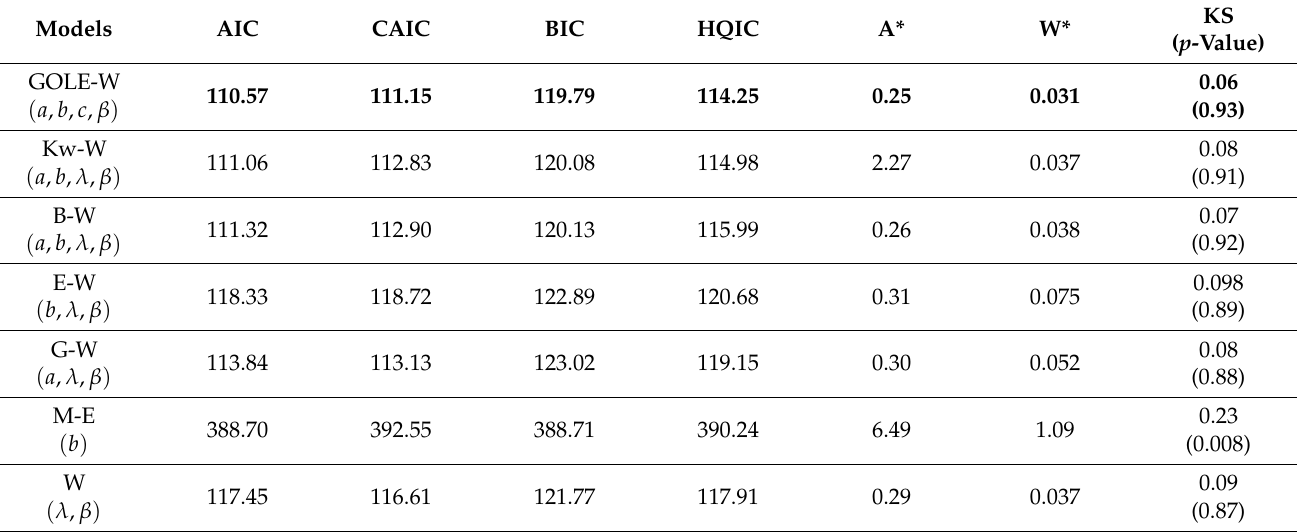
Table 10. The AIC, CAIC, BIC, HQIC, A*, W* and KS ( p -value) values for data set II.